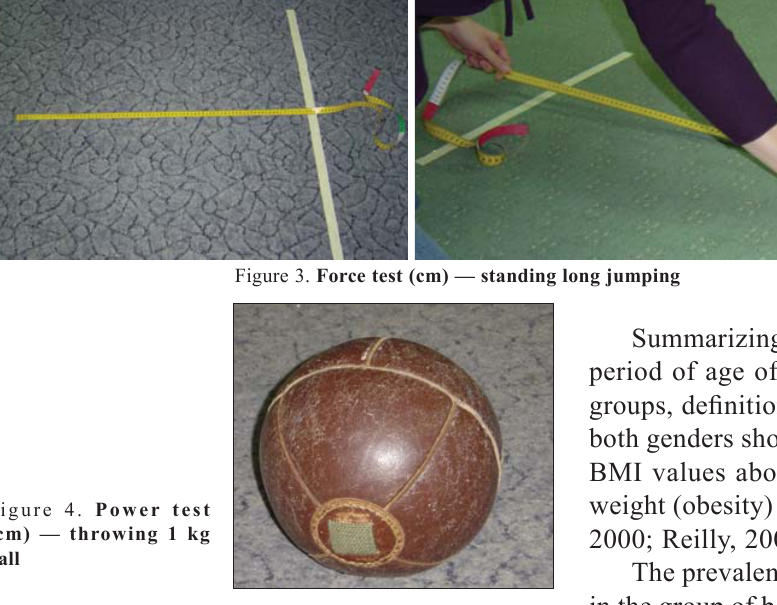
Figure 4. Power test (cm) — throwing 1 kg